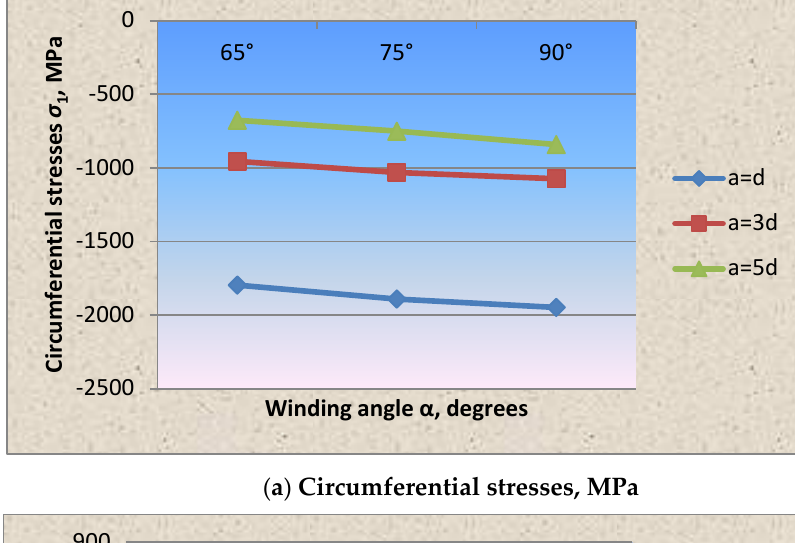
Figure 5. Dependence of the stress state parameter on the winding angle of the wrapping thread with the winding wire diameter of 1.0 mm. The same effect is observed in accordance with Figures 4 and 5 in the cylindrical shell wall fragment with a wire wrapping with a diameter of 1.0 mm and a pitch of 3d, 5d. As in the case of dense winding of the wire thread at an angle of 90°, the circumfer- ential stresses in the shell wall under the wire exceeded the axial ones by 11 times.